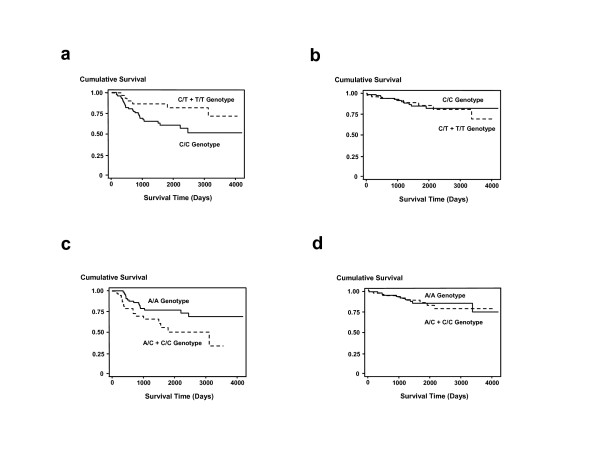
Association between MTHFR genotypes and breast cancer survival after stratification by ER-status. Shown are the Kaplan-Meier survival curves. (a) Cumulative survival of ER-negative patients by C677T status (n = 101). The survival of patients who carry the variant C677T genotype (n = 30; C/T or T/T) is significantly better than the survival of patients with the common genotype (n = 71; C/C). Log-rank test: p = 0.04. (b) Cumulative survival of ER-positive patients by C677T status (n = 144). The survival of patients who carry the variant C677T genotype (n = 50) is not significantly different from the survival of patients with the common genotype (n = 94). Log-rank test: p = 0.95. (c) Cumulative survival of ER-negative patients by A1298C status (n = 101). The survival of patients who carry the variant A1298C genotype (n = 38; A/C or C/C) is significantly worse than the survival of patients with the variant genotype (n = 63; A/A). Log-rank test: p = 0.02. (d) Cumulative survival of ER-positive patients by A1298C status (n = 143). The survival of patients who carry the variant A1298C genotype (n = 70) is not significantly different from the survival of patients with the common genotype (n = 73). Log-rank test: p = 0.68.